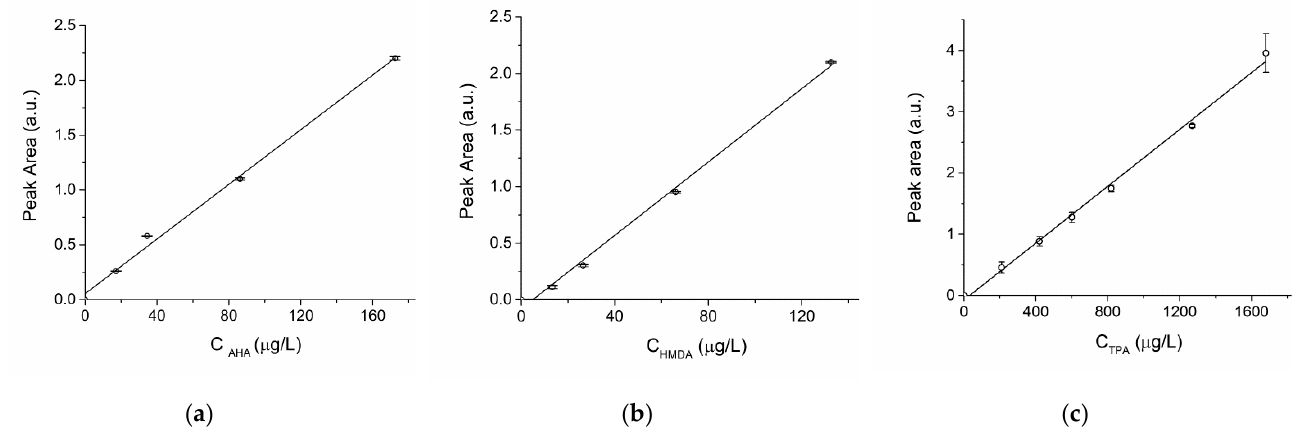
Figure 3. Linear regressions of the calibration dataset for the quantitative determination of the monomeric units: ( a ) AHA, with FLD (fitting parameters: peak area=0.01246 × C AHA + 0.05411; R2 = 0.99424); ( b ) HMDA, with FLD (fitting parameters: peak area = 0.01622 × C − 0.08077; R2 = 0.99466); ( c ) TPA, with UV detector (fitting parameters: peak area = 231955.9 × C − 7236.6; R2 = 0.99532). Each calibration was performed by running the measurements in triplicate.